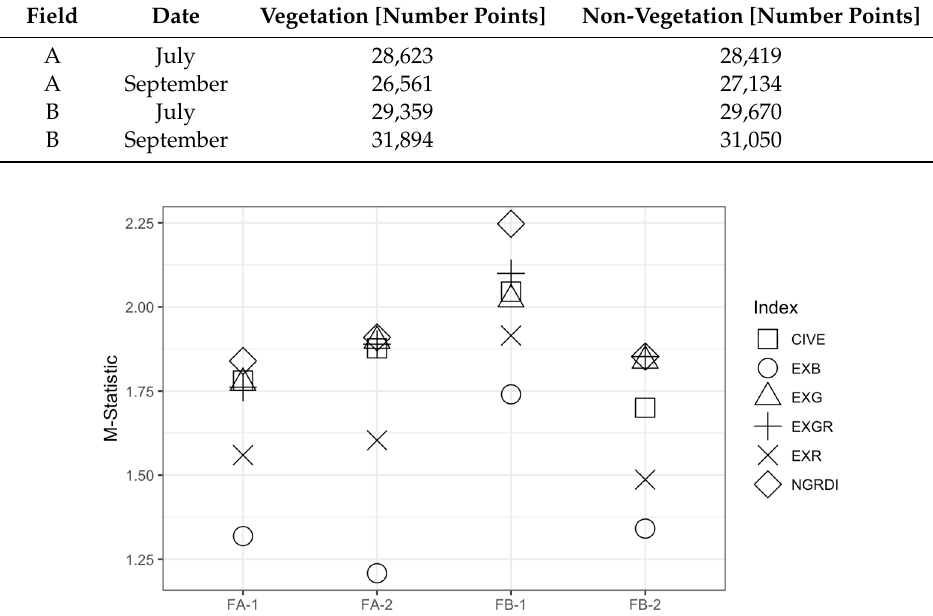
Table 3. Mean and standard deviation (SD) of each color vegetation index (CVI) per field and UAV flight date for the vegetation and non-vegetation classes and result of the M-statistic test.